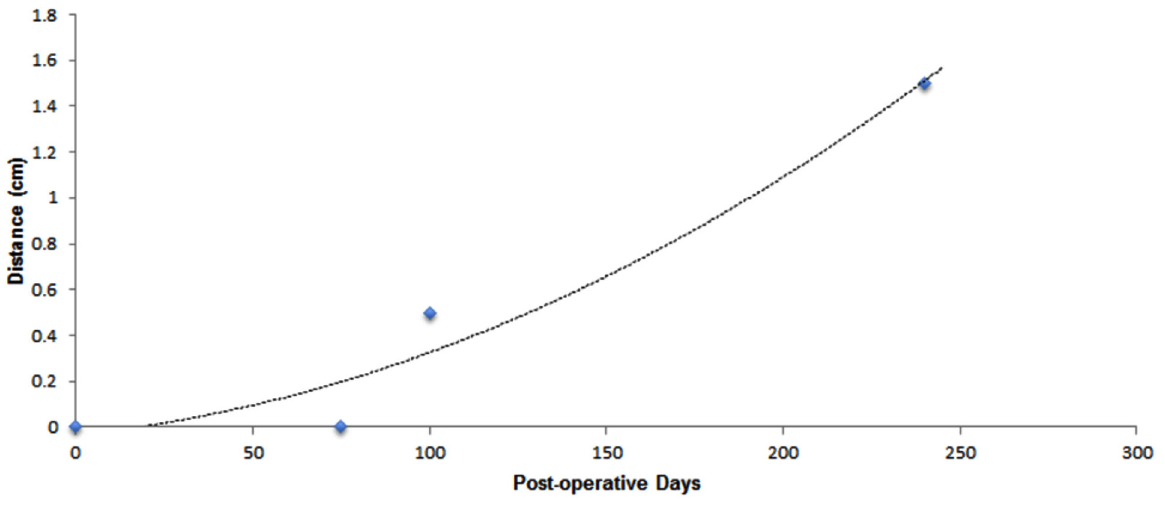
Figure 3. Collateral sprouting rate. Polynomial regression model demonstrating centripetal distance of collateral axonal sprouting from adjacent native skin as a factor of time since transplant with estimated rate of regeneration 0.06 mm per day.